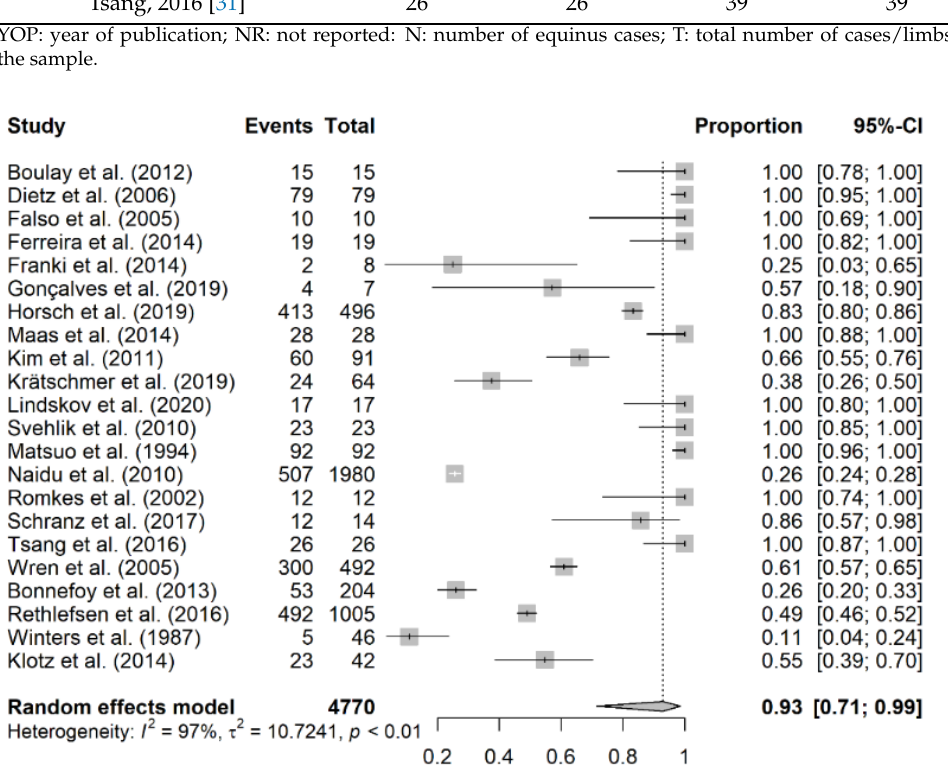
Figure 2. The pooled prevalence of equinus foot in cerebral palsy.